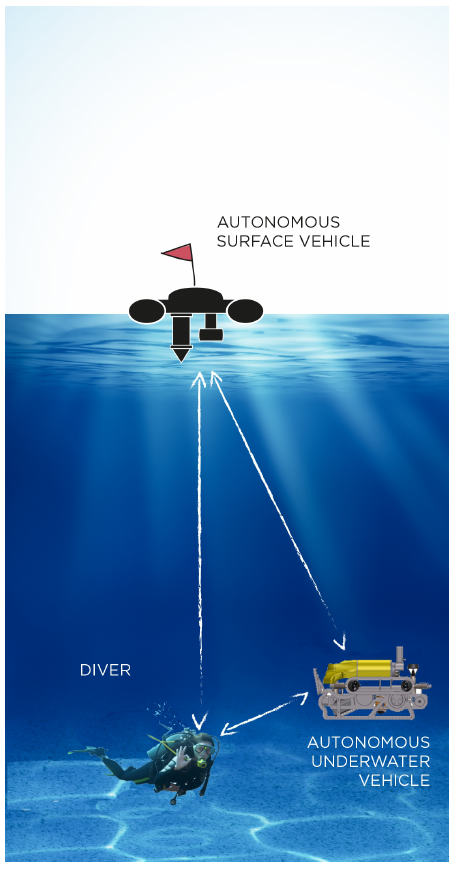
Figure 1. The CADDY (Cognitive Autonomous Diving Buddy)